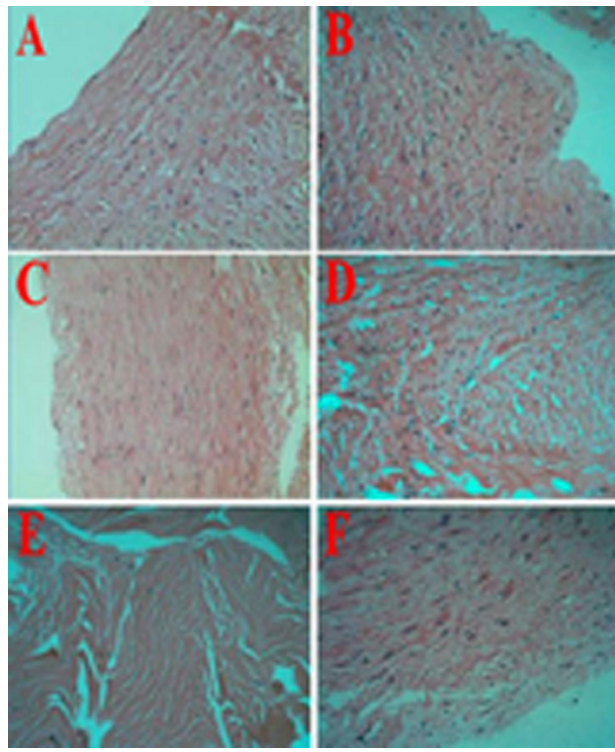
Fig. 1 - Microspcopic views of the grafts: (A) saphenous vein grafts with normal structures; (B) saphenous vein grafts showing medial degenerative changes with intimal proliferation; (C) radial arterial grafts with normal structures; (D) radial arterial grafts with medial degenerative changes with intimal proliferation; (E) internal mammary arteries with roughly normal structures; and (F) internal mammary arteries with mild degeneration of the media with intimal proliferation. Hematoxylin and Eosin staining × 200